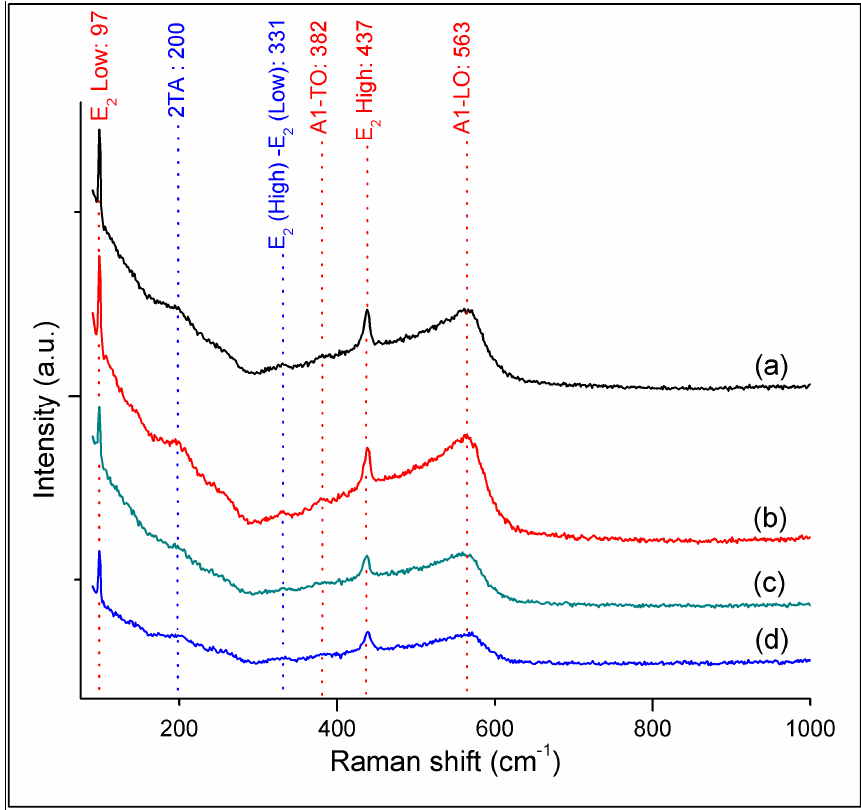
Figure 5. Raman shift from the samples of ( a ) undoped ZnO, and ZnO:Ta-doped films, grown with pellet weight of ( b ) 50 mg, ( c ) 200 mg, and ( d ) 300 mg of Ta 2 O 5 .